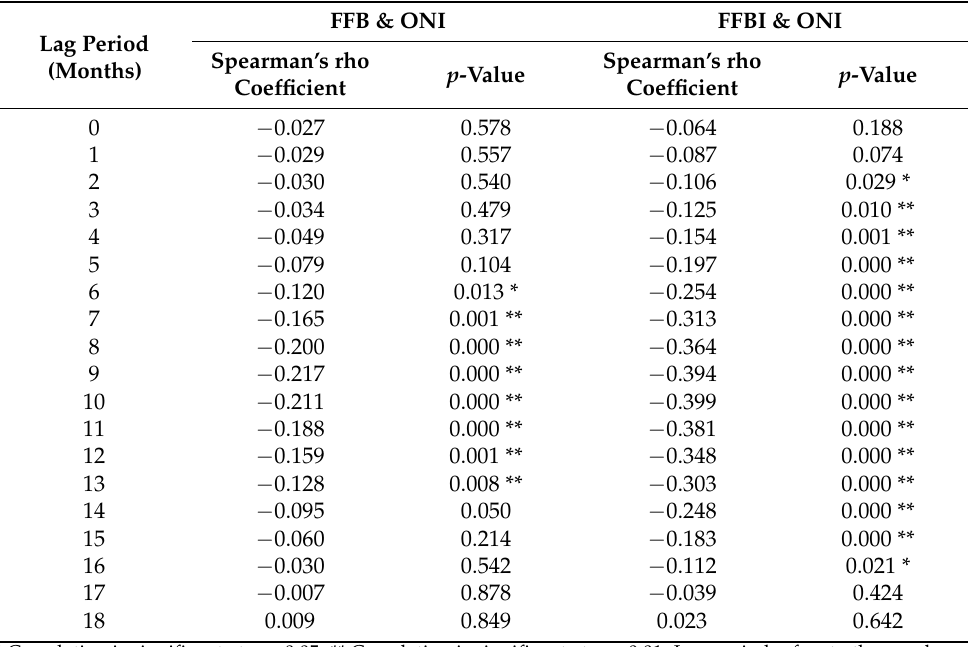
Table 5. Spearman’s rho correlation between FFB and FFBI with ONI at lag periods from 0 to 18 months.